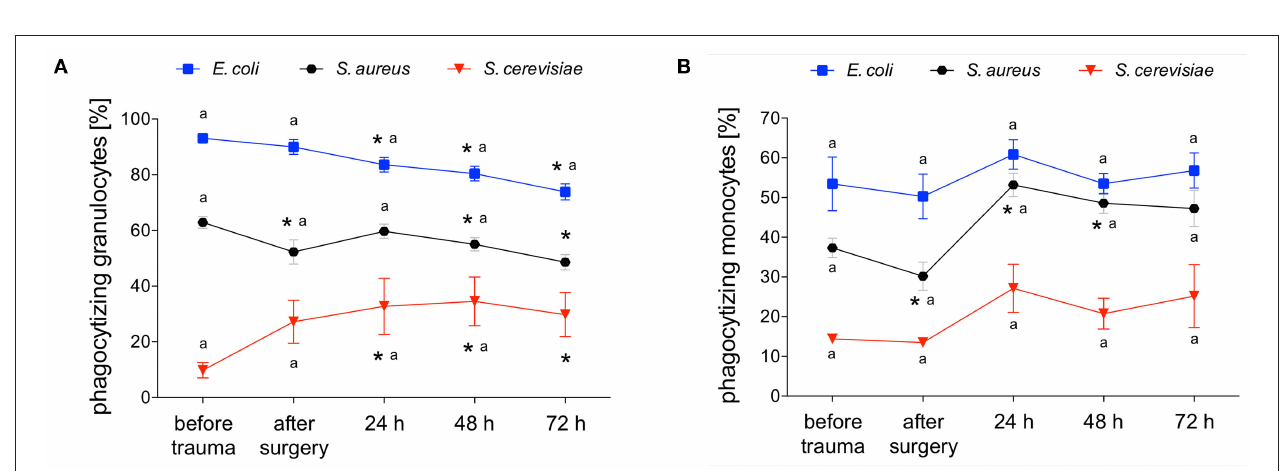
FIGURE 2 | Percentage of granulocytes and monocytes of viable leukocytes. The percentage of granulocytes (A) and monocytes (B) of viable leukocytes was measured with FACS-analysis before trauma, after trauma and after 24, 48 and 72h. Data are given as mean ± standard error of the mean, * p < 0.05 vs. baseline, n = 8.